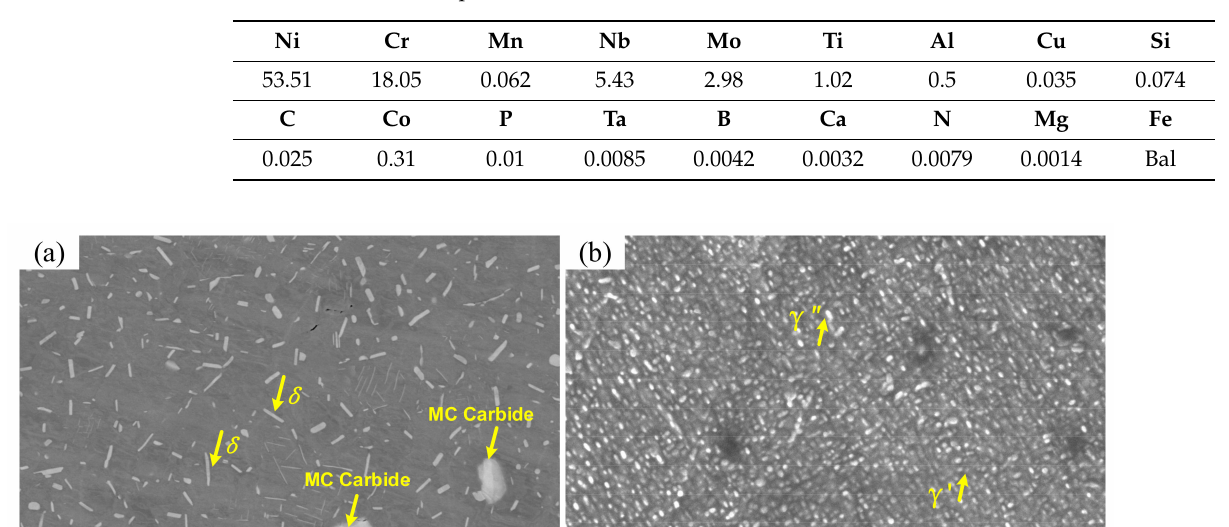
Table 1. Chemical composition of Inconel 718 (% wt).